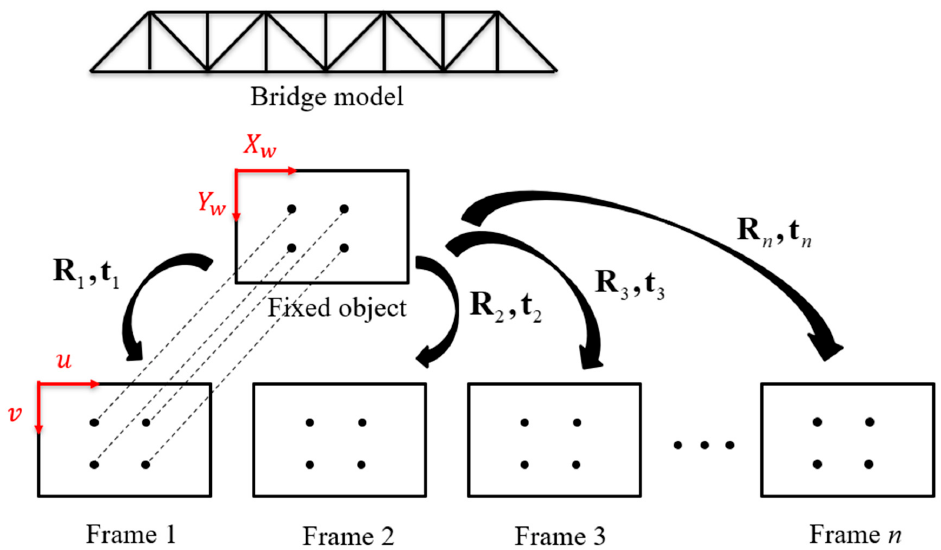
The extrinsic matrix represents the position and orientation of the UAV camera for different moments. As shown in Figure 4, the upper left corner of the fixed object plane can be set as the origin of the world coordinate system, the horizontal direction is the Y axis. Once A is known, the UAV extrinsic ma- axis, and the vertical direction is the w trix can be computed by at least four sets of world coordinates and their corresponding image pixel coordinates.